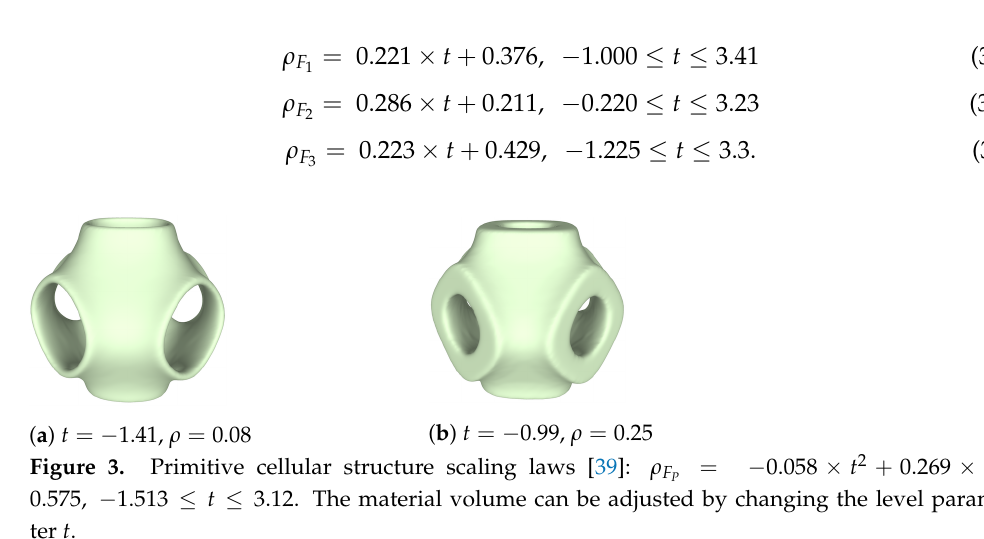
= − 0.058 × t 2 + 0.269 × t + P